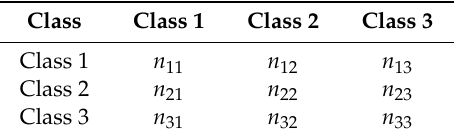
Table 2. Template of a confusion matrix for a 3-class classifier.